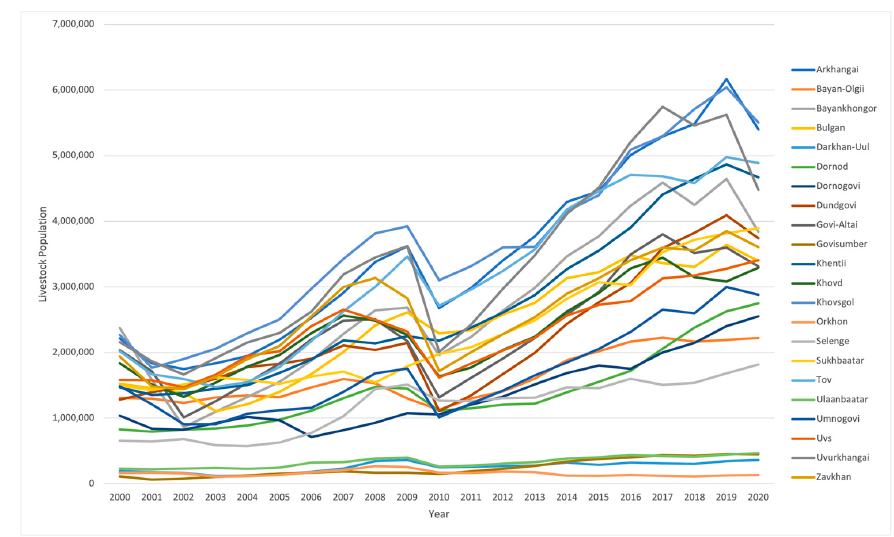
Figure 1. Total livestock population per province from 2010 to 2020.